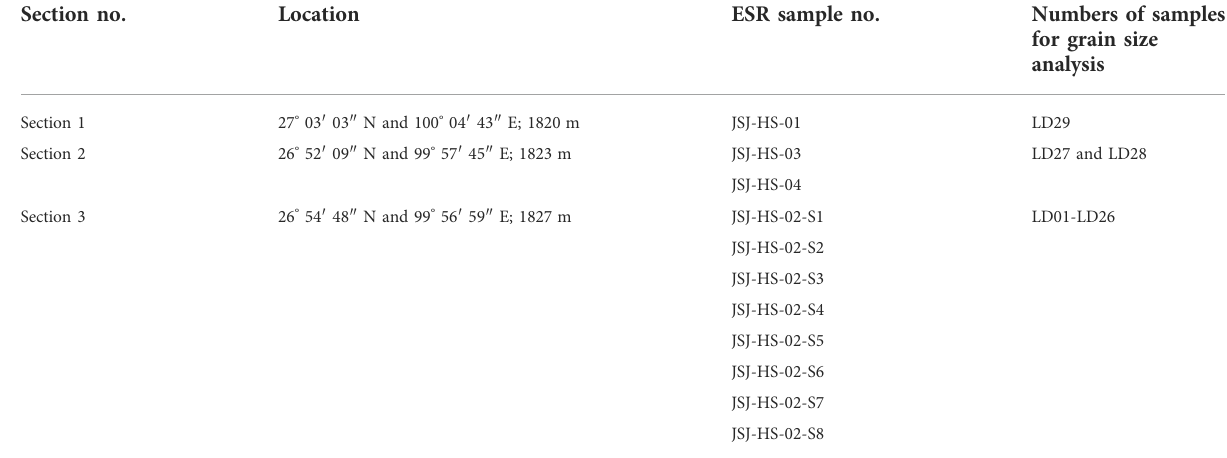
TABLE 1 Details of sampling information for ESR dating and grain size analysis. Section no.